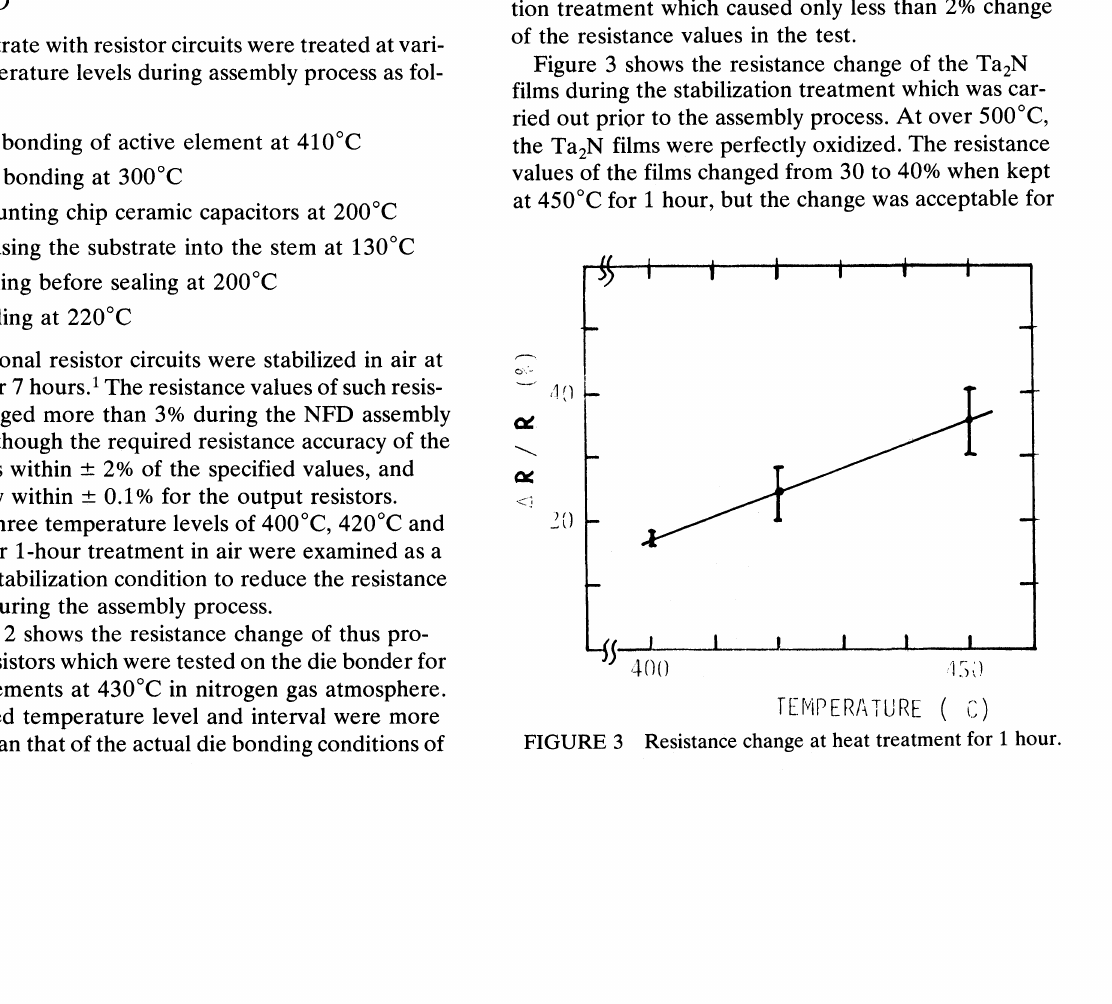
Schematic cross section of the NFD.